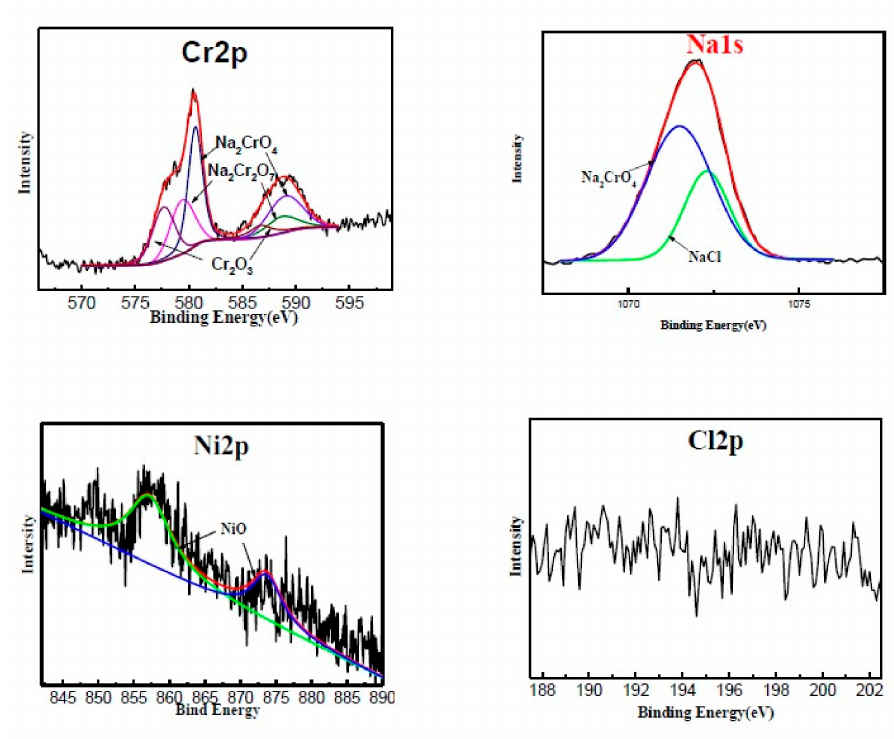
Figure 9. The XPS spectra of Cr 2p, Na 1s, Ni 2p, and Cl 2p of the collecting volatile corrosion